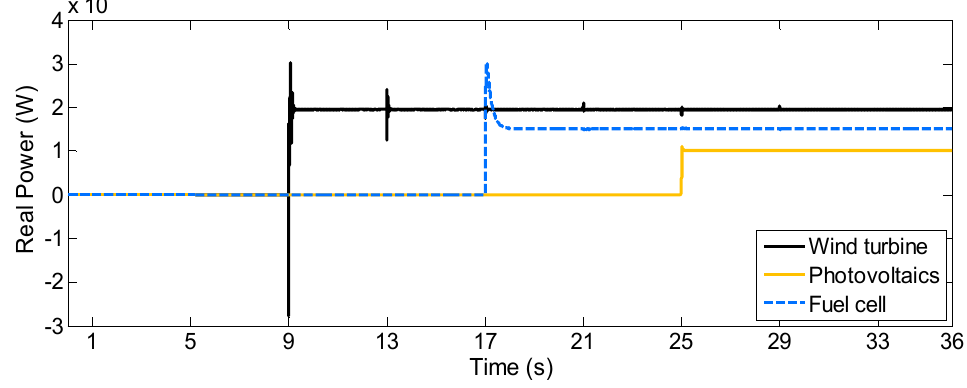
Figure 14. Frequency of the MG during the restoration process.